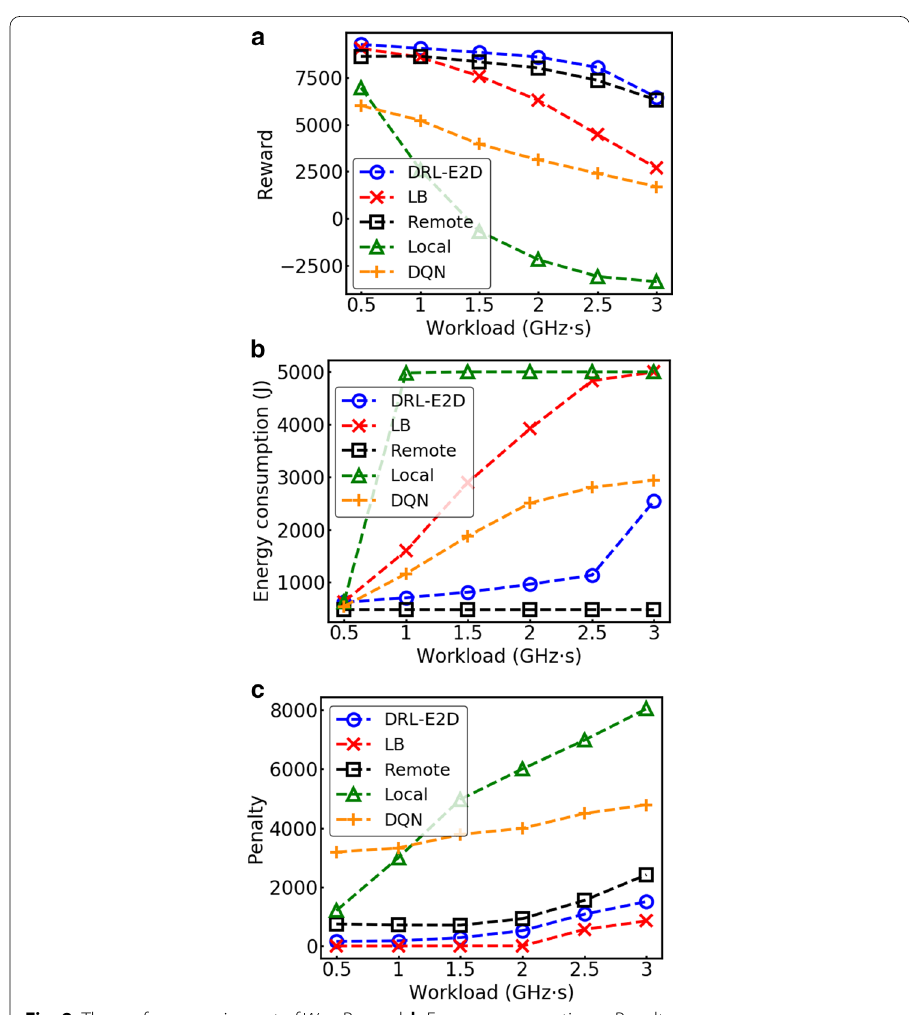
Fig. 8 The performance impact of W . a Reward. b Energy consumption. c